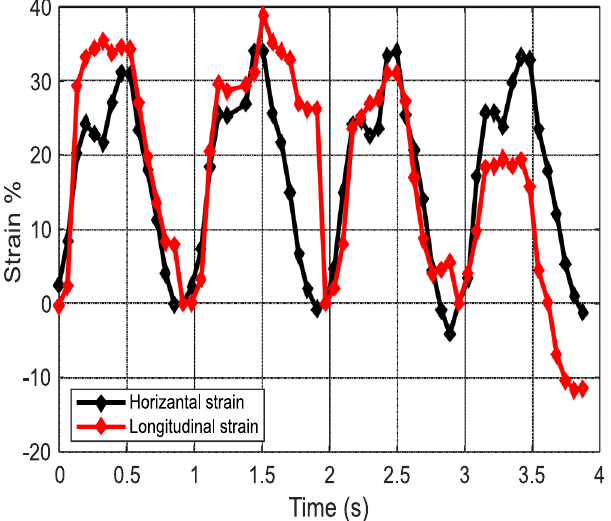
Figure 10. Horizontal and longitudinal strains as a function of time obtained by